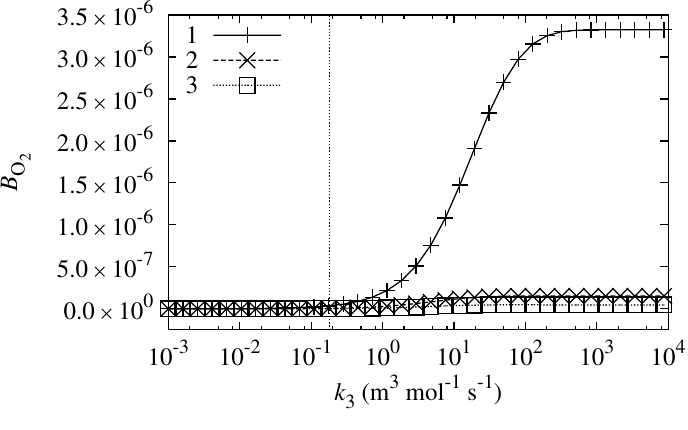
Figure 5. The biosensor response sensitivity, B , to oxygen dependence on reaction rate O 2 constant of Reaction (7), k , at different values of substrate concentration s : 0 . 498 mol/m 3 3 0 (1), 4 . 98 mol/m 3 (2) and 49 . 8 mol/m 3 (3). The vertical line marks the reaction rate constant, k , corresponding to N-methylphenazonium methyl sulfate (PMS). 3